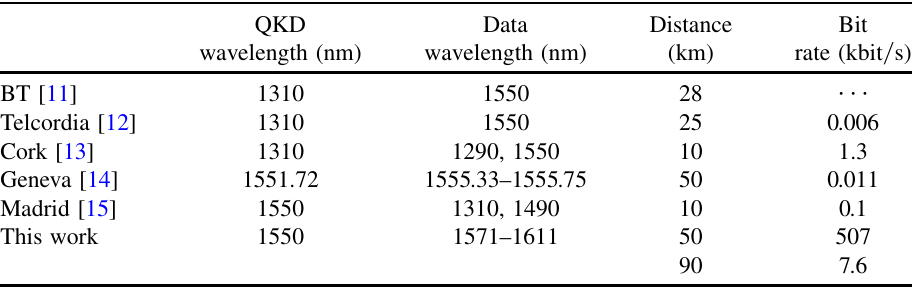
TABLE I. Summary of existing quantum and data multiplexing